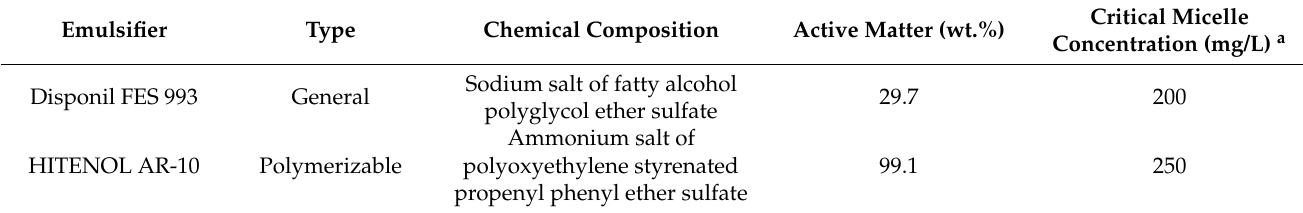
Table 1. Characteristics of the